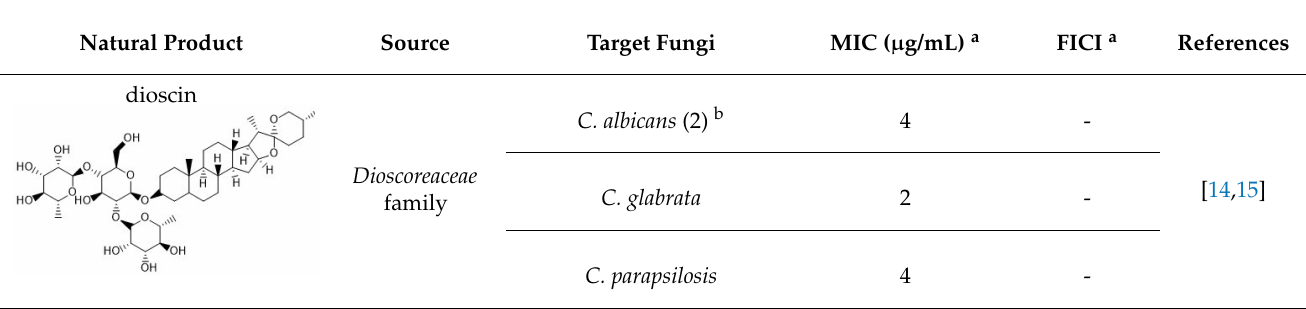
Table 1. Natural products from TCMs and their antifungal